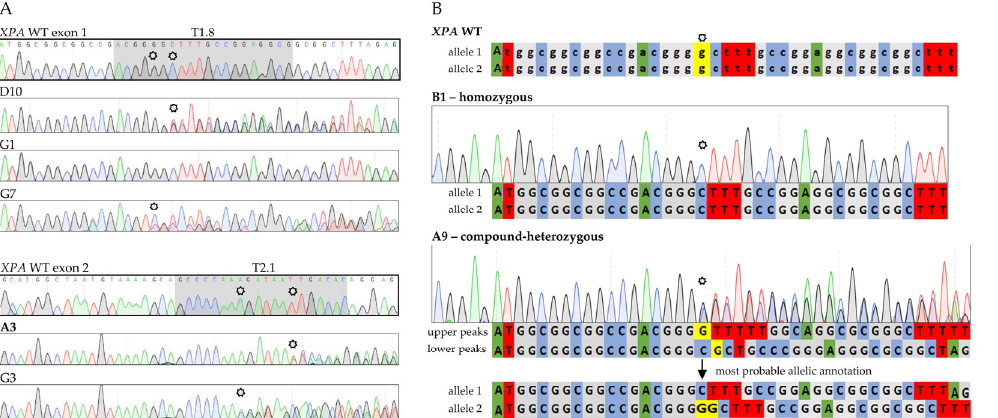
Figure 3. Analysis of CRISPR/Cas9-generated single cell-derived lines. ( A ) Sanger sequencing chromatograms of XPA exon 1 (targeted with sgRNA T1.8) and exon 2 (targeted with sgRNA T2.1) illustrating the different outcomes. Monoclonal G1 cells remained unaltered, while all other depicted subclones carried mutations on both alleles. WT DNA regions targeted with the two different sgRNAs are highlighted in gray ( B ) Sequencing chromatograms of XPA WT and XPA exon 1 knockouts with depiction of underlying alleles. Stars indicate mutation start sites in the subclones as well as the original bases in the WT. Selected cell lines written in bold. The detailed description of the allelic assignment process can be found in the Material and Methods Section 4.3. sgRNA , single-guide RNA; WT , wildtype; A , adenine (green); C , cytosine (blue); G , guanine (gray); T , thymine (red).